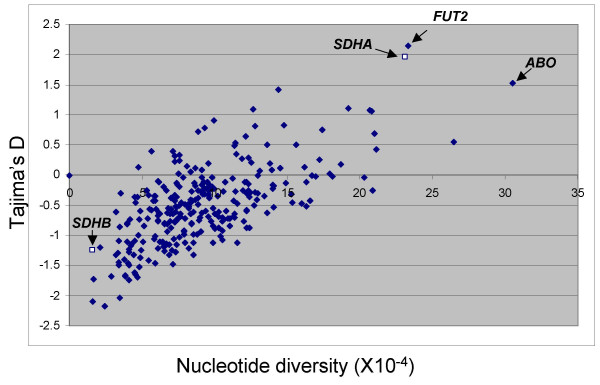
Tajima's D statistic and nucleotide diversity in SDHA and SDHB genes (squares) relative to the 282 genes in SeattleSNP database are shown in the African American population. Positions of two highly polymorphic loci, ABO and FUT2, the latter of which encodes the alpha(1,2)fucosyltransferase, are shown.